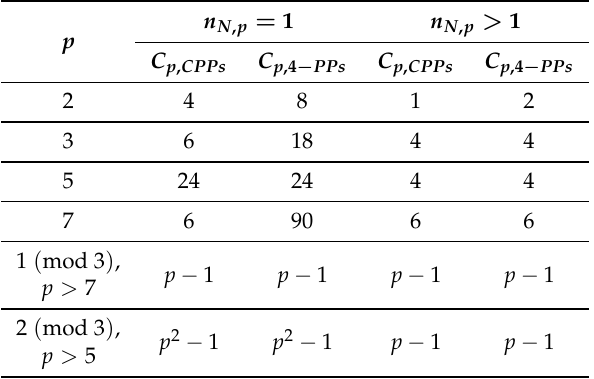
, with n N , p ≥ 1. p nN , p